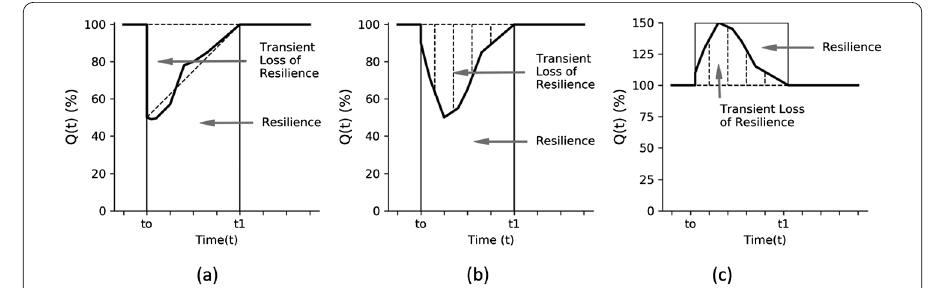
Figure 1 Calculation of resilience and transient loss of resilience. ( a ) Resilience triangle (adopted from [10]), ( b ) Human mobility resilience (decreased movement), ( c ) Human mobility resilience (increased movement)